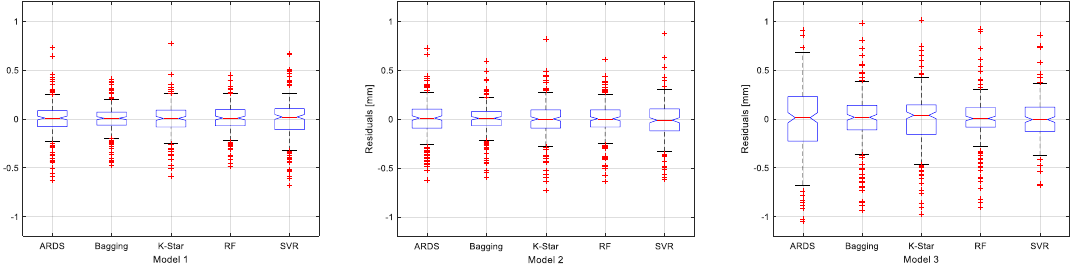
Figure 8. Equivalent diameter prediction: box plots of the residuals.